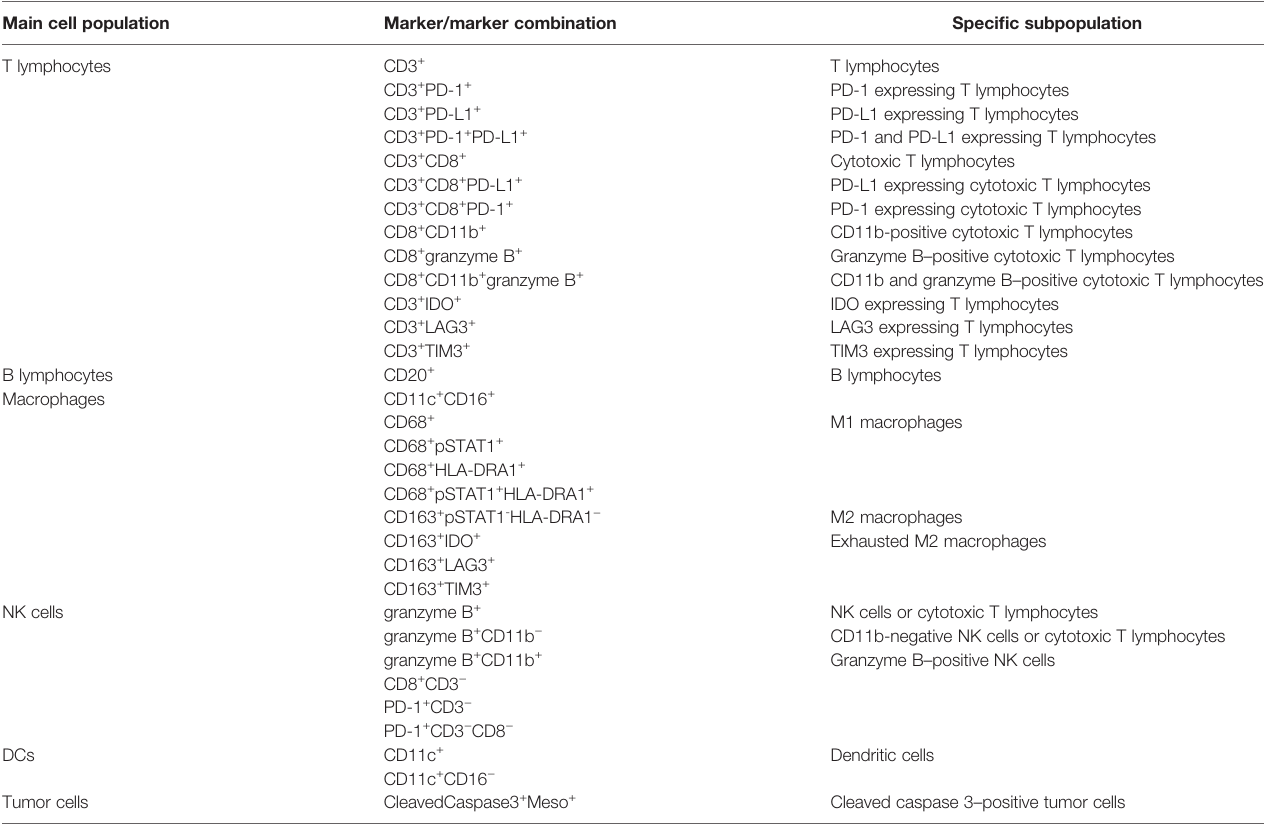
TABLE 1 | Immune cell markers and the main marker combinations analyzed in this